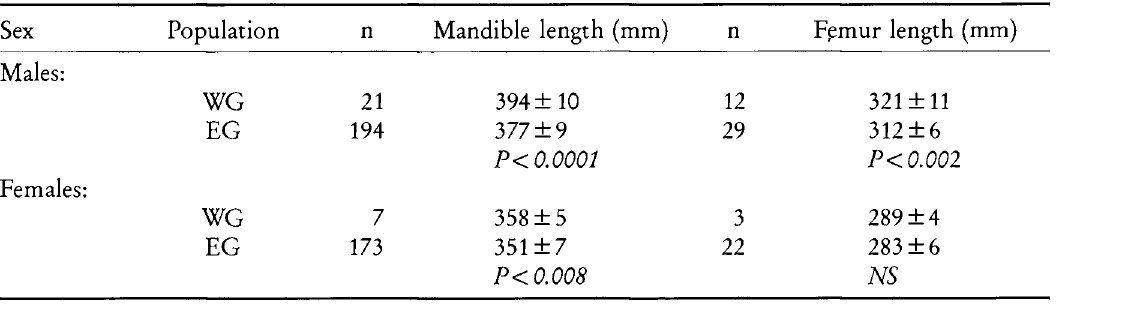
Table 2. Length of mandibles and femurs in adult muskoxen (4+ years) from Angujaartorfiup Nunaa, West Greenland (WG) and Jameson Land, East Greenland (EG). Mean ± SD.